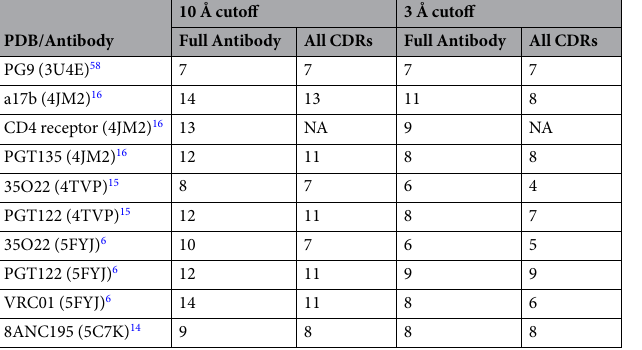
Table 3. Number of glycans that approach within 10 or 3 Å of the modeled antibodies for the entire antibody and for all of the complementary-determining regions (CDR) of each